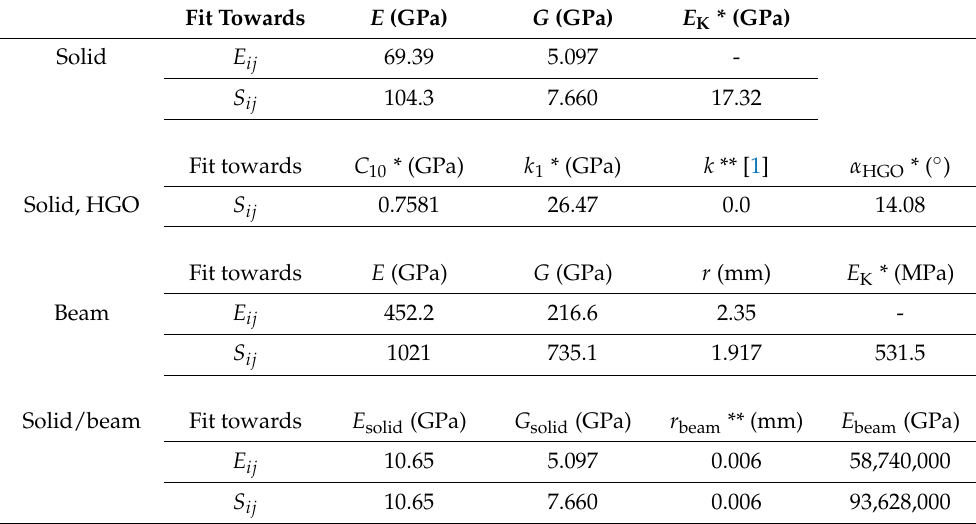
Table 6. Material and geometry parameters for the efficient cable models from analytical calculation or calibration by FEM